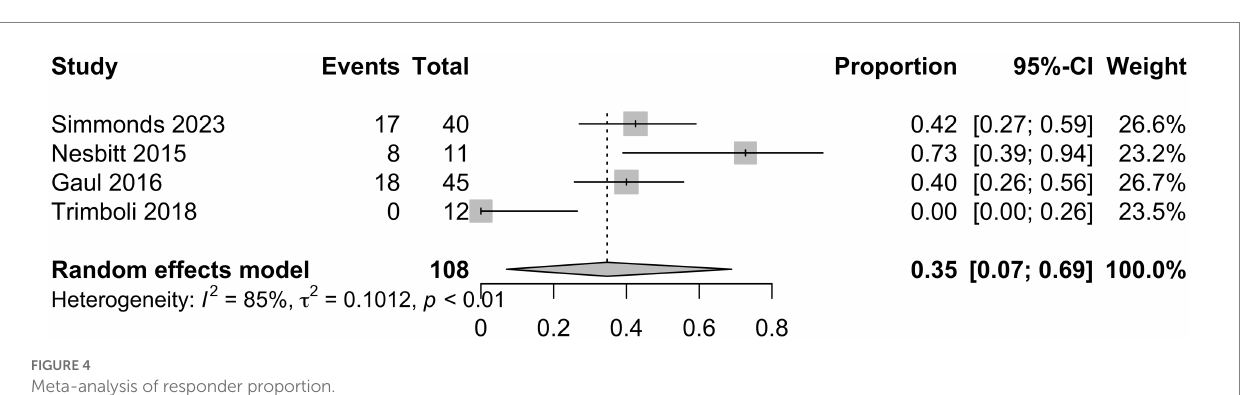
FIGURE 4 Meta-analysis of responder